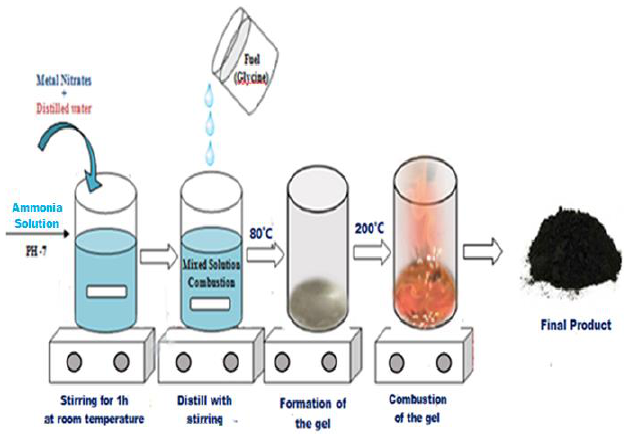
Fig.1. Schematic illustrations of synthesis procedure.